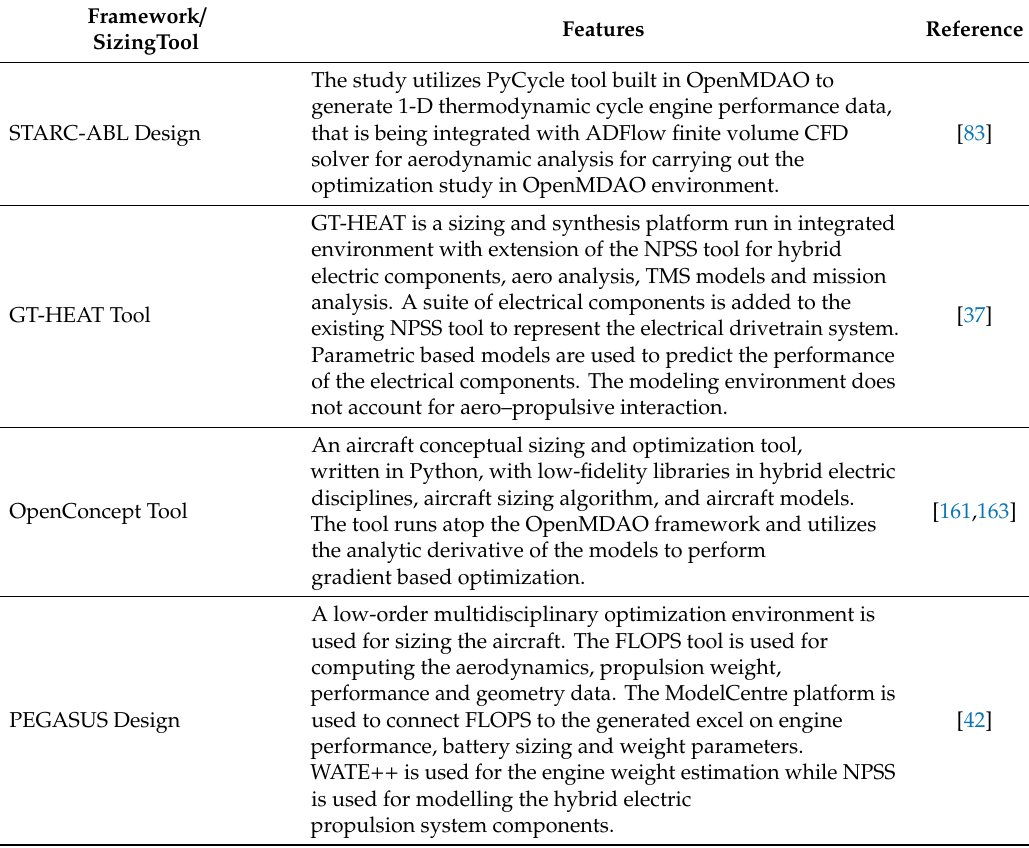
Table 3. Aircraft sizing tools used for electric aircraft